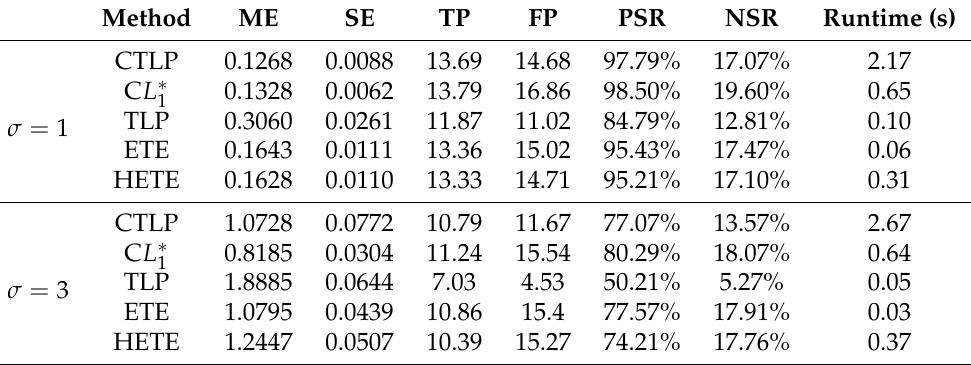
Table 6. The comparison of four methods in the case of n < p , AR ( 1 ) correlation matrix without group